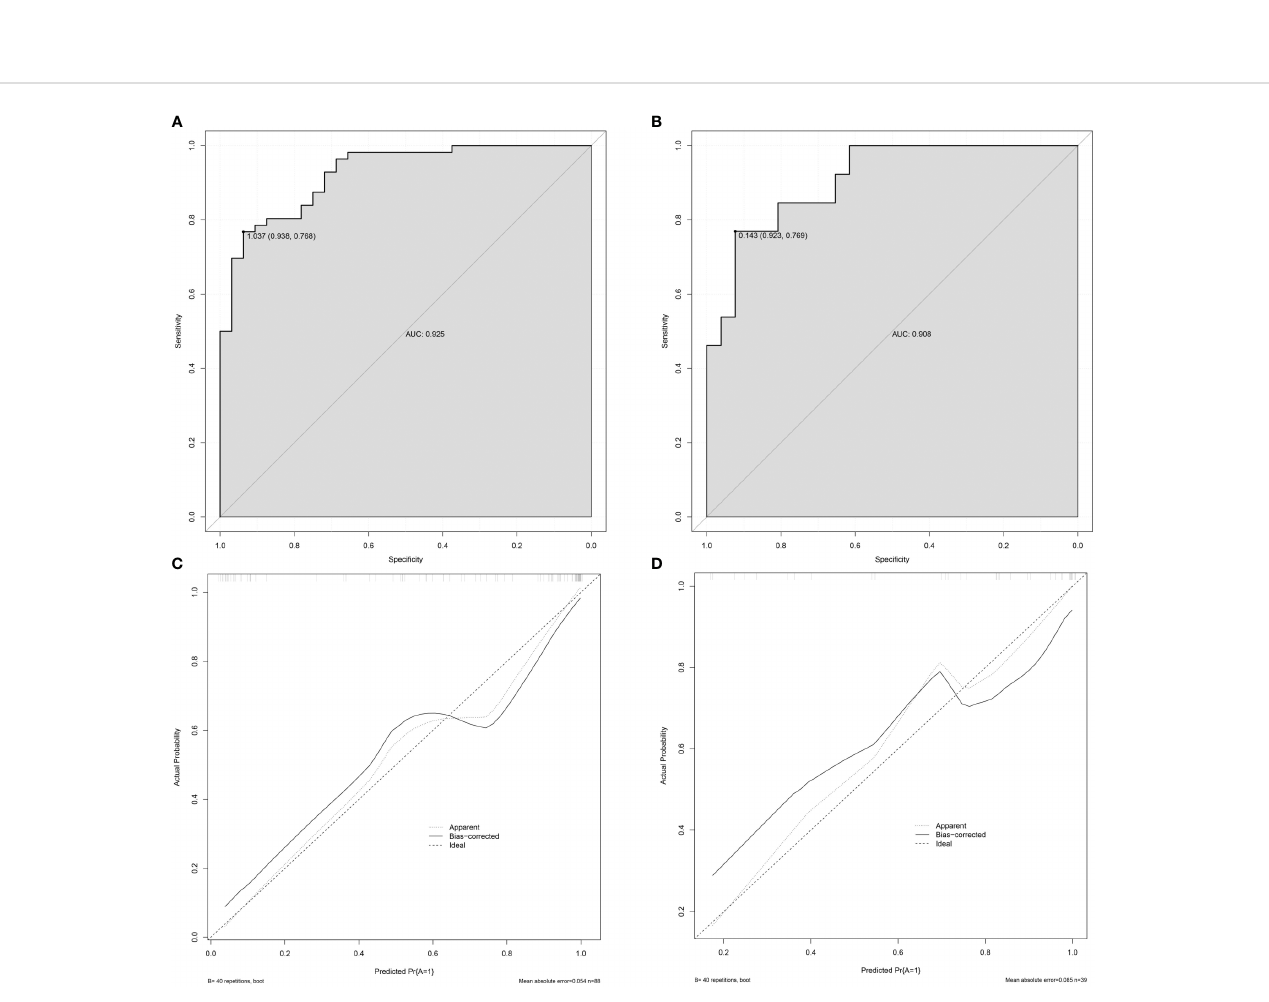
FIGURE 4 Validation of the nomogram. (A) The AUC of the prediction model in the training cohort was 0.925, 95% CI: 0.872 – 0.978. (B) The AUC of the prediction model in the validation cohort was 0.908, 95% CI: 0.816 – 1.000. (C) The calibration curve of the nomogram in the training cohort. (D) The calibration curve of the nomogram in the validation cohort. The x-axis is the predicted probability of the nomogram, and the y-axis is the actual probability of GPC- 3 positive expression. The calibration prediction curve fi ts well with the standard curve, suggesting that the predicted probability of GPC-3 positive expression by the nomogram model is in good agreement with the actual probability. Note: ideal is the standard curve, apparent is the prediction curve, and bias-corrected is the calibration prediction